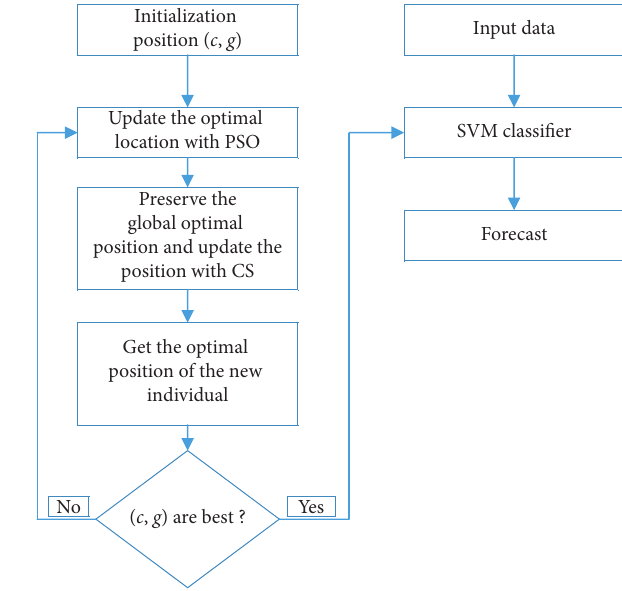
Figure 7: Calculation process of PCSVM.